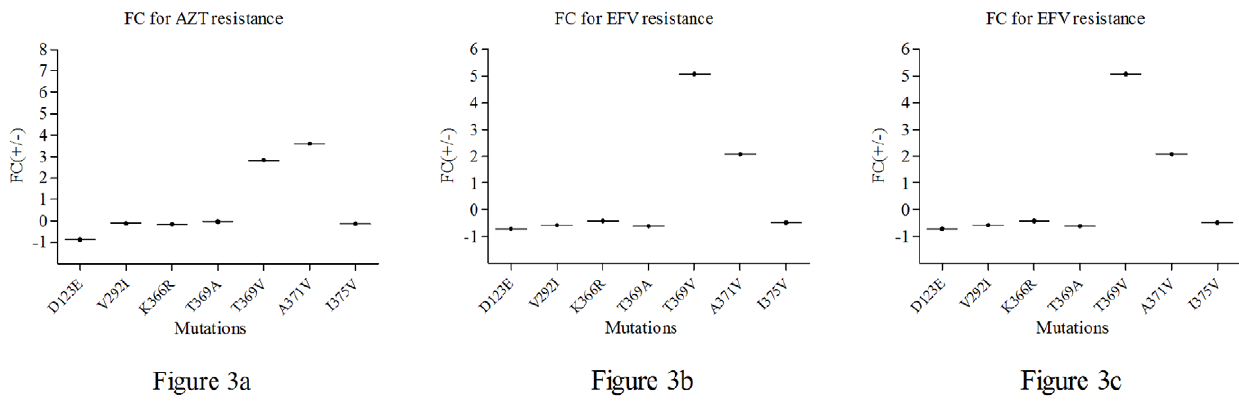
Figure 3. Fold change in the response of mutant viruses to antiviral drugs. When IC 50 of the mutant virus was greater than that of the wild- type virus, the fold change(FC) was calculated as IC 50 of mutant virus/wild-type virus and then indicated as positive ( + ); When IC 50 of the mutant virus was less than that of the wild-type, the fold change was indicated as negative ( 2 ). Figure 3a Fold change in the response of mutant viruses to AZT. Figure 3b Fold change in the response of mutant viruses to EFV. Figure 3c Fold change in the response of mutant viruses to NVP.